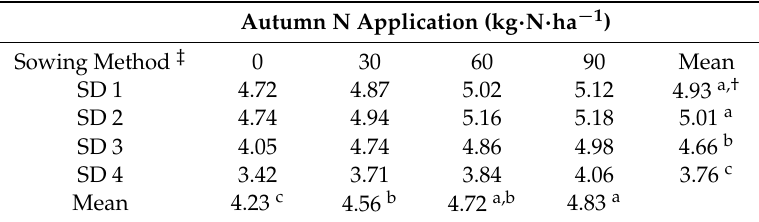
Table 1. Sowing method by autumn N application interaction effects on winter oilseed rape ( Brassica napus L.; WOSR) seed yield (t · ha − 1 ) (based on the average of 2009/2010, 2010/2011, 2012/2013 and all spring